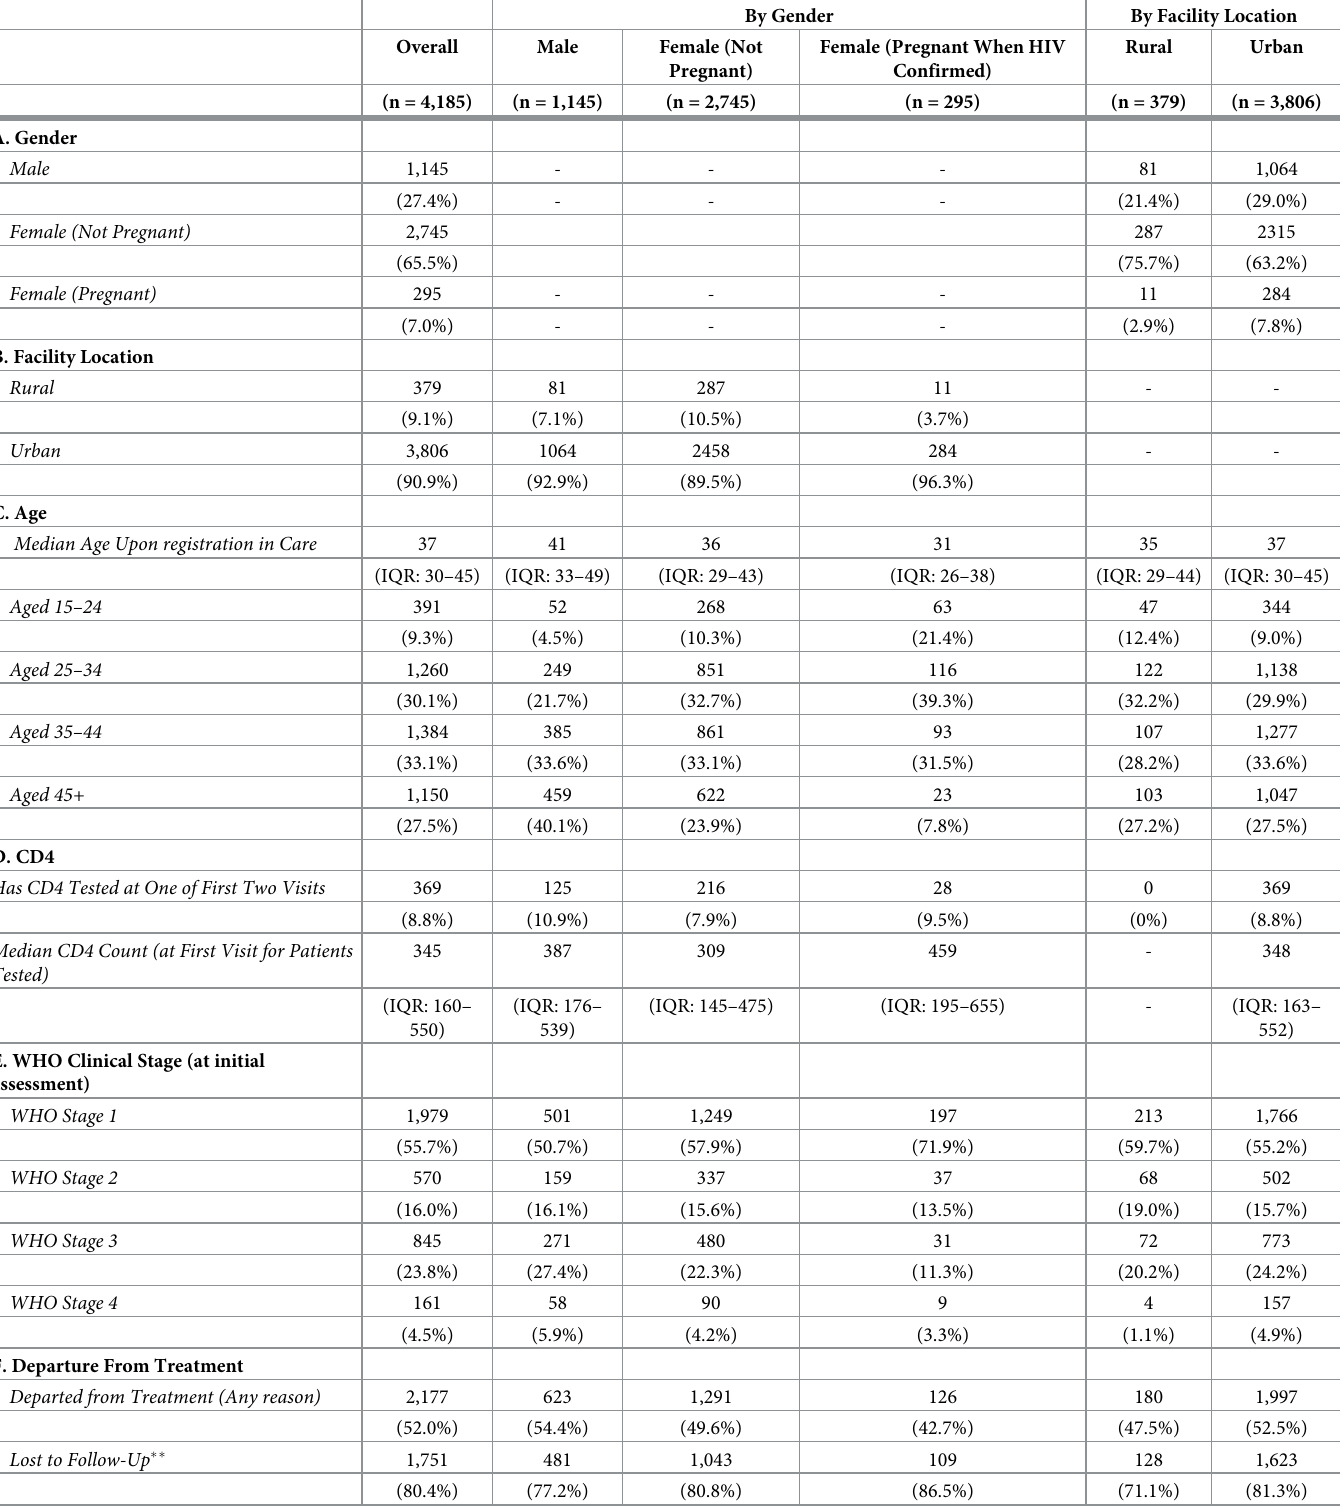
Table 1. Characterization of demographical, clinical, and programmatic parameters of the cohort at baseline and outcomes at 24 months of follow-up.